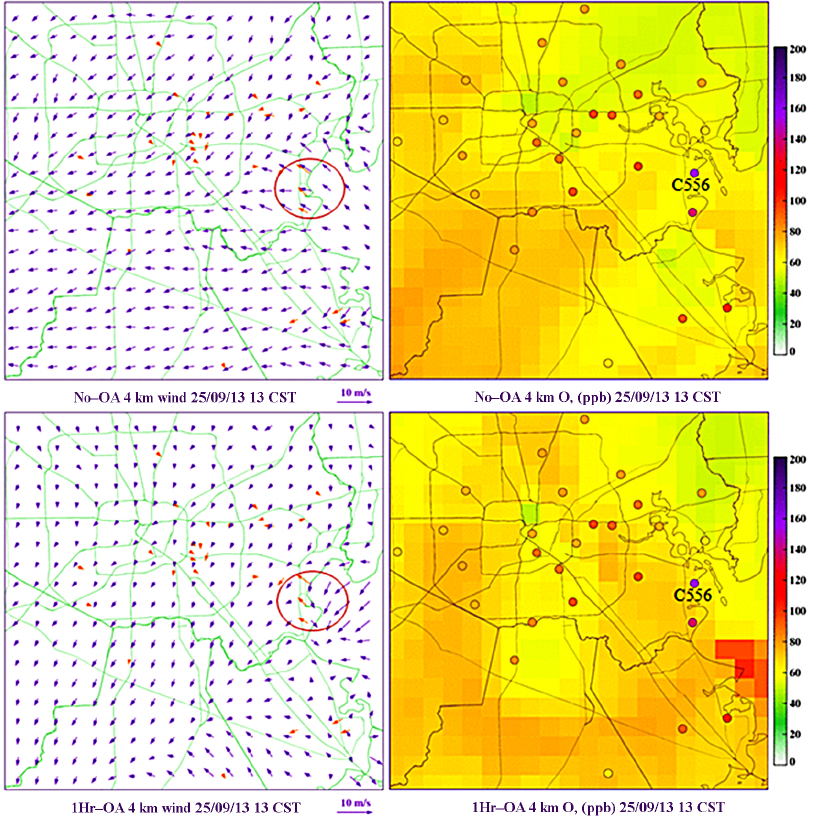
Figure 10. Zoom-in ozone concentrations (right panels) and wind plots (left panels) at 13:00CST on 25 September for No-OA (top panels) and 1Hr-OA (bottom panels). Ozone observation is in the small circle; wind observation is indicated by an orange arrow. Bay breeze is shown in the orange oval. The numerical range of the right-side color scale is 0 to 200ppb. Higher values than 200ppb have the same color as 200ppb.